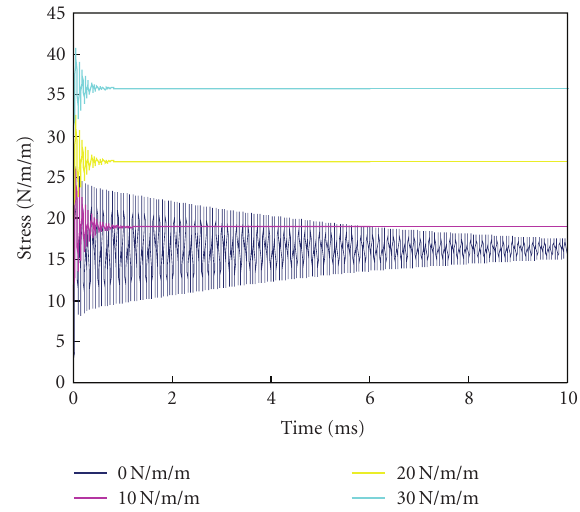
Figure 6: Stresses near the root of an electrostatic fixed-fixed actuator for various residual